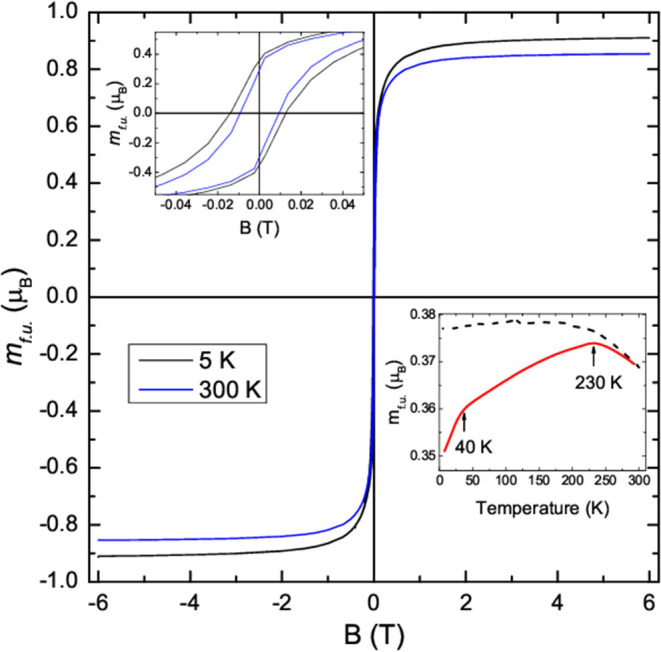
Plot of the moment per formula unit, mf.u., against temperature at 5 K (black curve) and 300 K (blue curve). An expanded view is plotted in the upper right inset. Lower left plot: plot of the ZFC and FC mf.u. against temperature for an applied magnetic field of 10 mT.